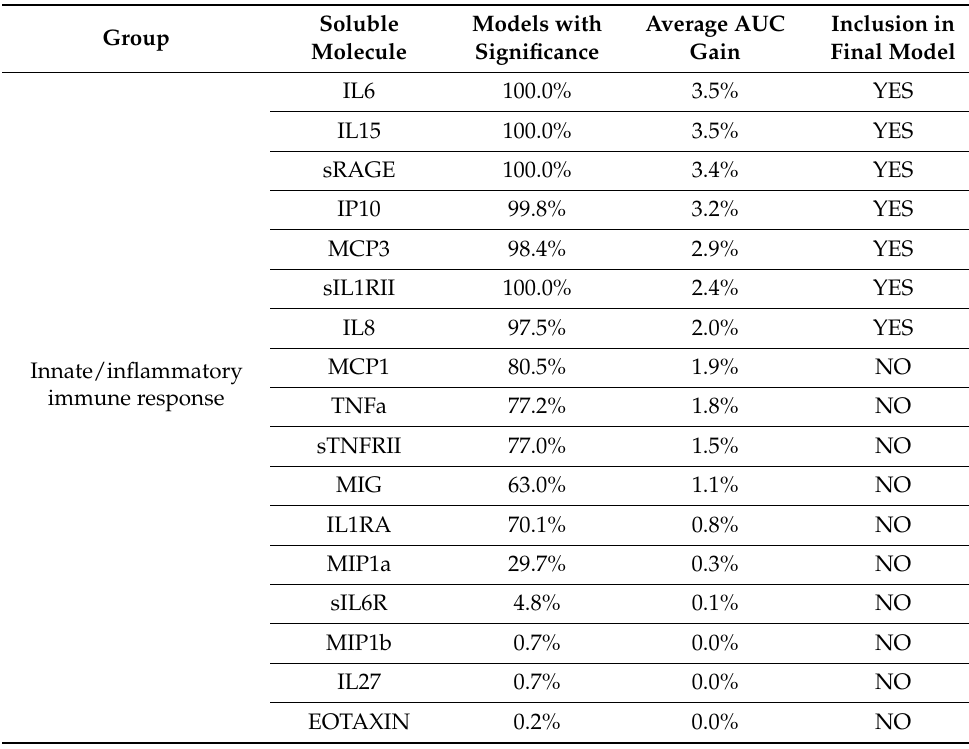
Table 2. Cont. Group